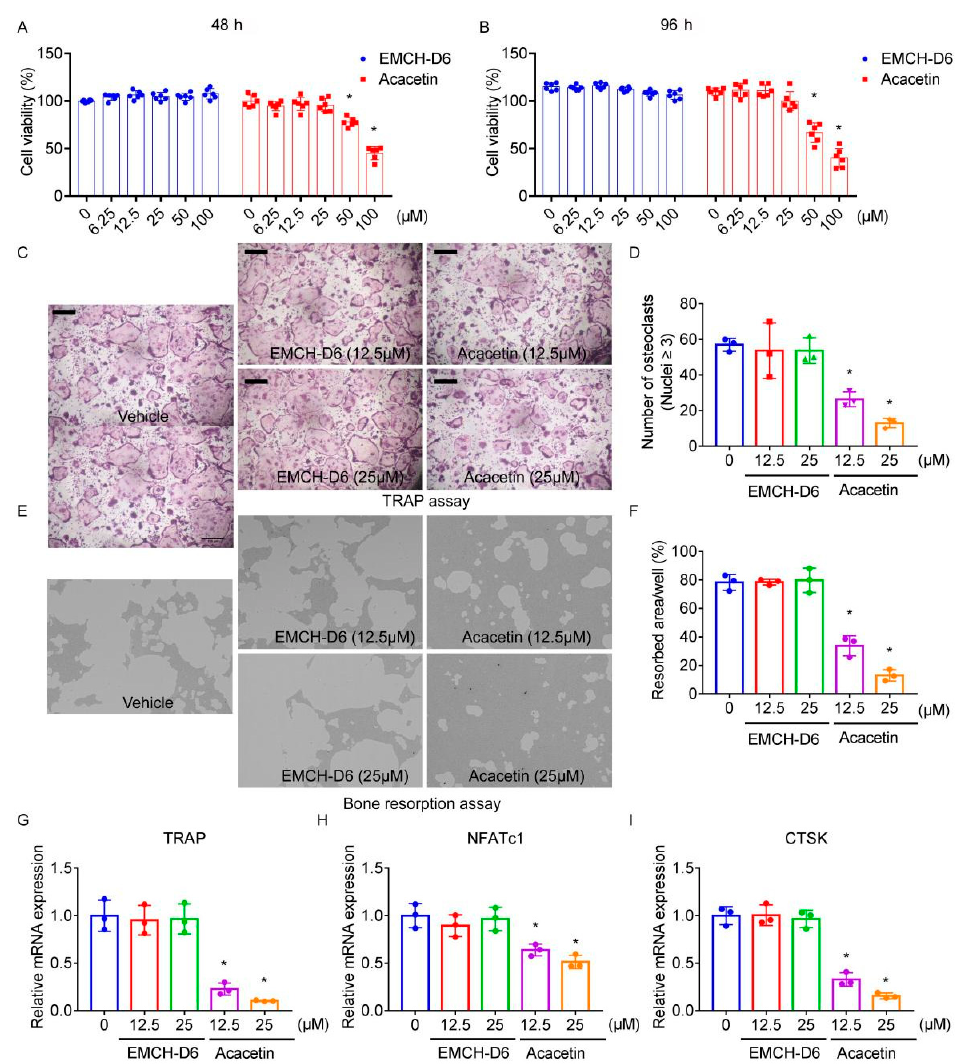
Figure 2. BMMs (8 × 10 3 cells/well) were seeded to 96-well and treated with acacetin or EMCH-D6 (0, 6.25, 12.5, 25, 50, 100 µ M) for 48 h ( A ) and 96 h ( B ), n = 6. The cytotoxic effects of acacetin or EMCH-D6 on BMMs proliferation were detected using the CCK-8 assay. BMMs were stimulated with RANKL (50 ng/mL) and M-CSF (25 ng/mL) in the presence of acacetin or EMCH-D6 (12.5, 25 μ M) for 7 days. TRAP-positive multinucleated osteoclasts ( ≥ 3 nuclei) were counted using TRAP assay ( C , D ). BMMs (2 × 10 4 cells/well) were seeded in Osteo Assay Surface plate and stimulated with RANKL (50 ng/mL) and M-CSF (25 ng/mL). After immature osteoclasts were formed, acacetin or EMCH-D6 (12.5, 25 μ M) were added for 3 days. Bone resorption area was quantified ( E , F ). BMMs were stimulated with RANKL (50 ng/mL) and M-CSF (25 ng/mL) in the presence of acacetin or EMCH-D6 (12.5, 25 μ M) for 3 days. The mRNA expression of TRAP ( G ), NFATc1 ( H ), and CTSK ( I ) were assayed by RT-PCR. * p < 0.05 versus the vehicle-treated group, n = 3.